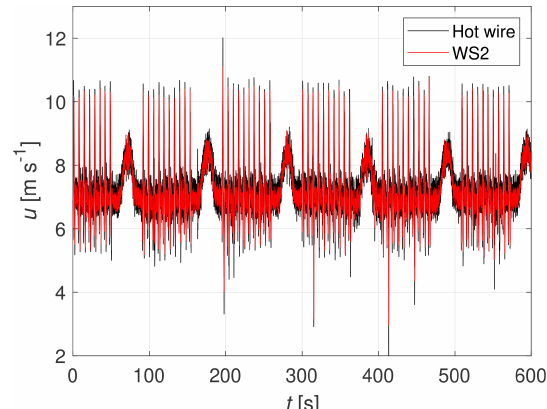
Figure 14. The 10min time series measured by WindScanner 2 and the hot-wire anemometer for a coefficient of variation of 12.9% (Case